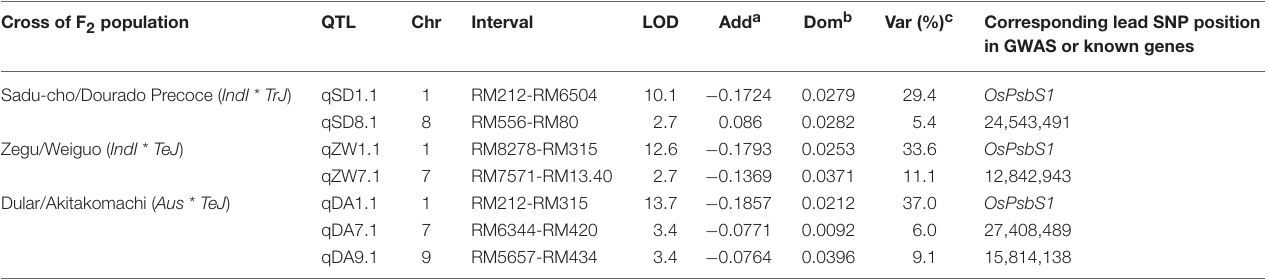
a Additiveeffects.PositivevaluesindicatethattheallelefromSadu-choorZeguorDularcanincreasethephenotypicvalue,whereasnegativevaluesindicatetheallelefromthecounterpart parent Dourado Precoce or Weiguo or Akitakomachi can increase the phenotypic value. b Dominance effect. Positive values imply that the heterozygotes had higher phenotypic value than the means of the two homozygotes, whereas negative values imply that the heterozygotes had lower phenotypic value than the means of the two homozygotes. c Variance